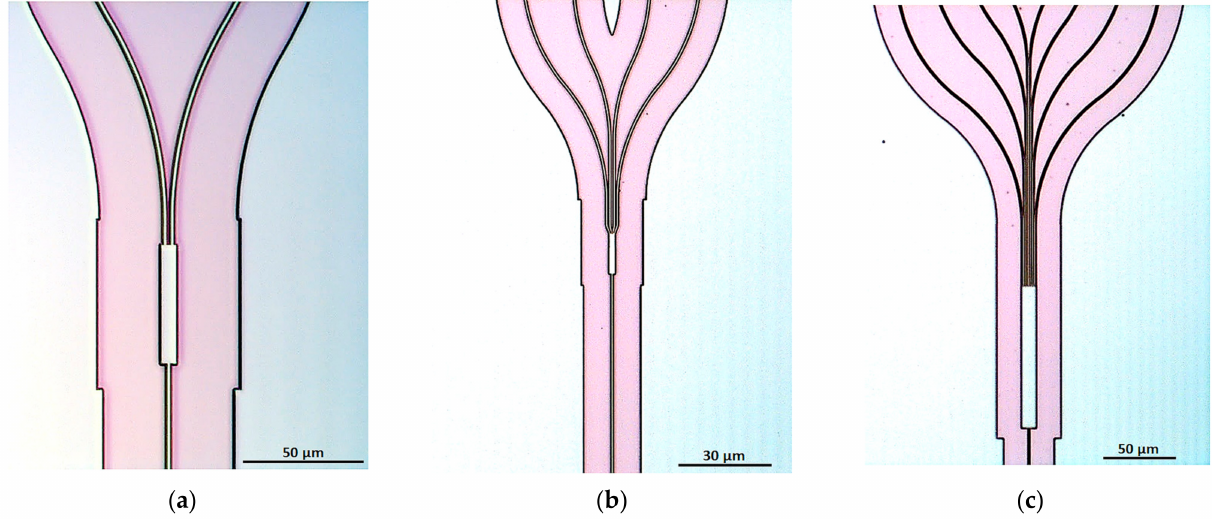
Figure 16. Optical microscope images of MMIs: ( a ) 1 × 2; ( b ) 1 × 4; and ( c ) 1 × 8 optimized for 660 nm operation.